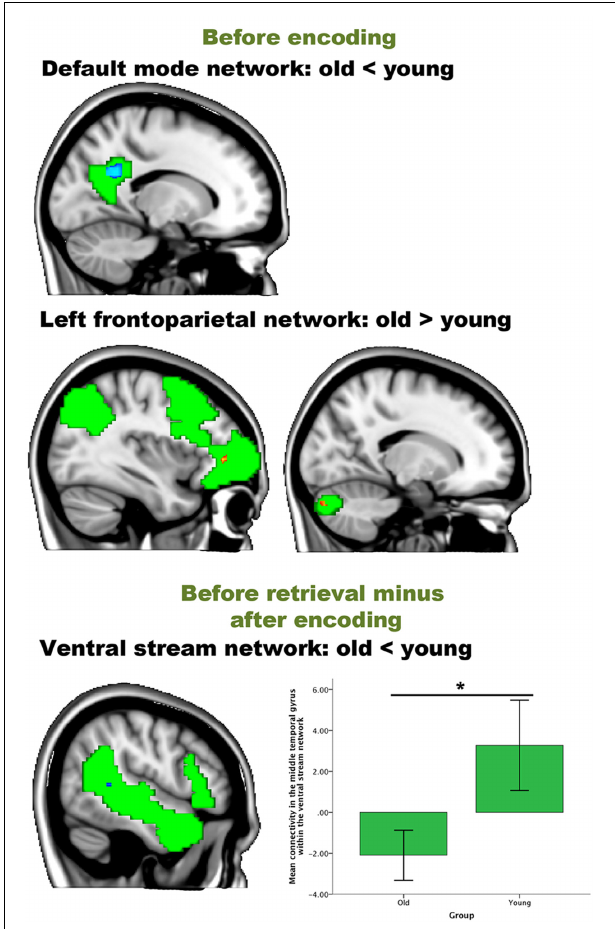
FIGURE 6 | Resting-state differences between older and young within the networks of interest. Within-network group differences were found for the contrasts “before encoding” and “before retrieval minus after encoding.” Blue clusters show decreased connectivity in older adults, red clusters indicate increased connectivity in older adults. The bar chart depicts the group differences between the lateral temporal cortex and the ventral stream (error bars indicate 1 standard error) ∗ p -value <